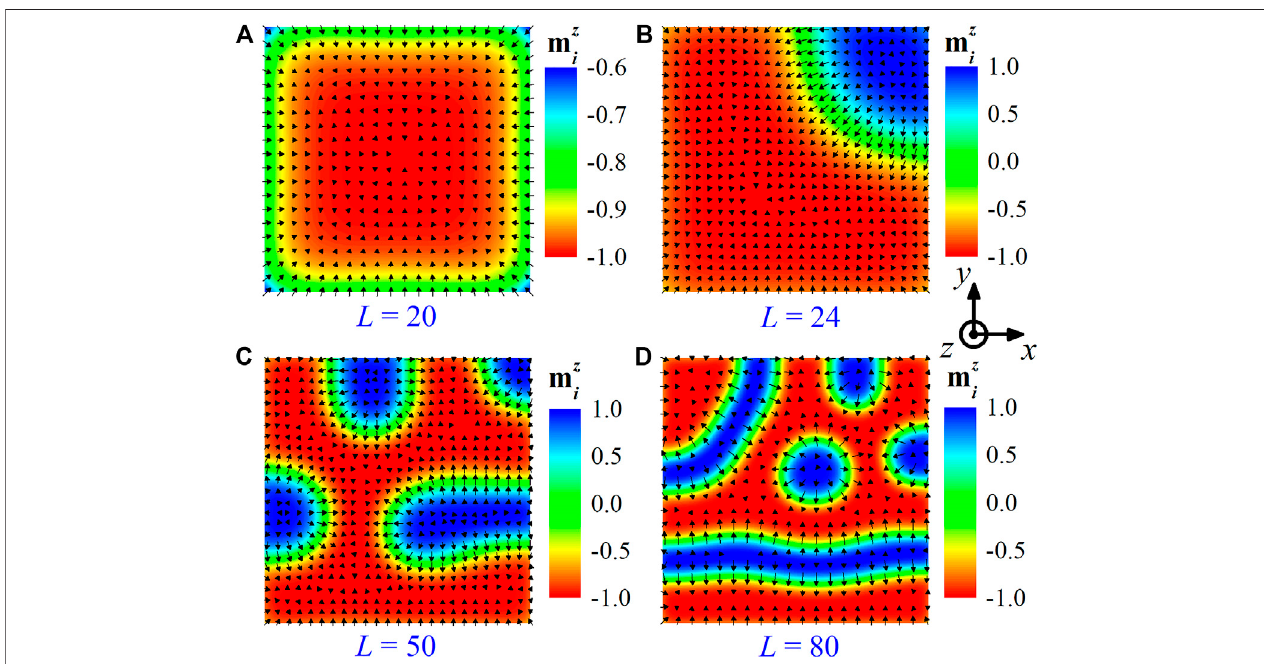
FIGURE 1 | Size effect of nanostructures on the equilibrium magnetic states. Some typical magnetic con fi gurations are shown for square-shaped nanostructures with lateral sizes of (A) L (cid:2) 20 ( ∼ 10nm), (B) L (cid:2) 24 ( ∼ 12nm) (C) L (cid:2) 50 ( ∼ 25nm), and (D) L (cid:2) 80 ( ∼ 40nm). Here the magnetic fi eld B z (cid:2) − 0 . 008 J FM ( ∼ − 0.1T) is applied along the − z -axis. To illustrate the magnetic con fi gurations, we used the color map to scale the magnetization components along z -axis (out-of-plane)m z i , and used the arrows to describe the on-plane xy componentsm xy i